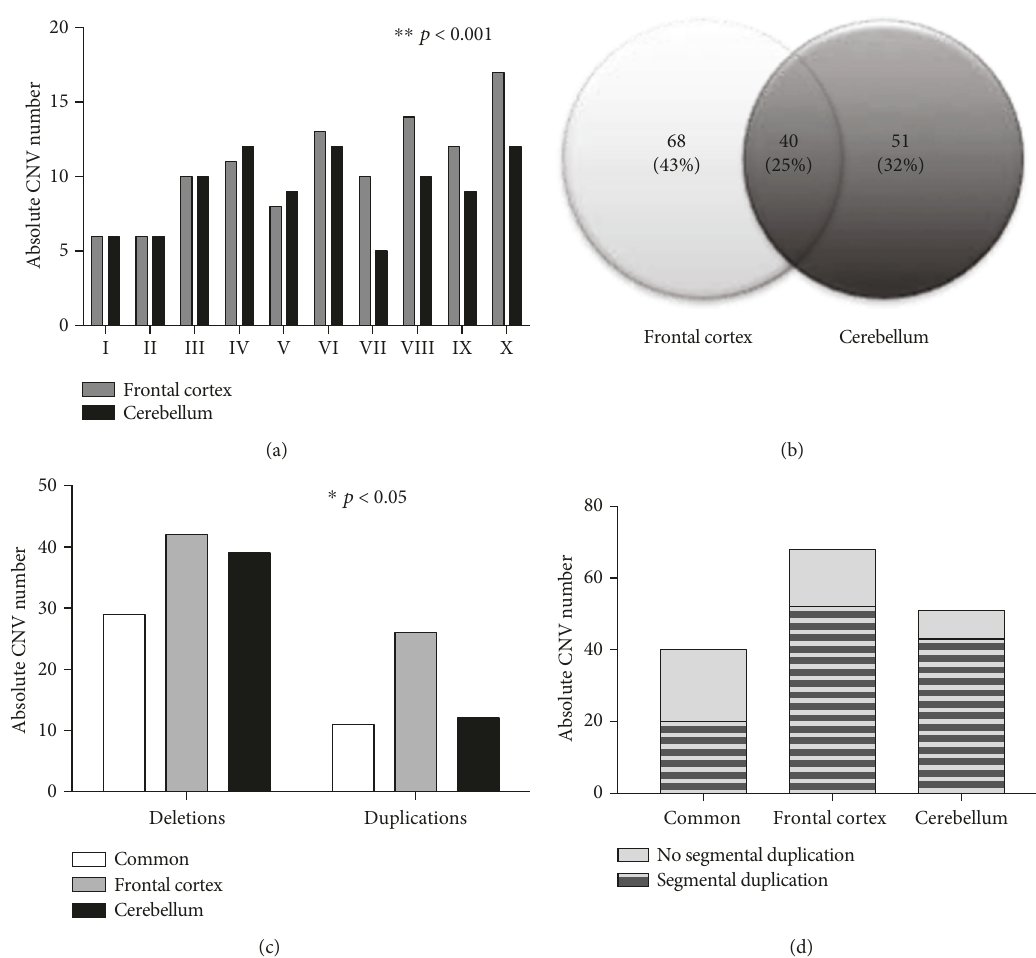
Figure 2: Distribution of DNA copy number variations (CNVs) between two neural tissues from the same individuals. (a) Comparison of the absolute number of CNVs detected in the frontal cortex and cerebellum from 10 paired individuals; ∗∗ p < 0 001 for comparison between individuals, two-way ANOVA. (b) Venn diagram showing the proportion of CNVs observed in the frontal cortex and cerebellum. (c) Total number of deletions and duplications observed in the CNVs in common to both neural tissues and in the unique CNVs from the frontal cortex and cerebellum; ∗ p < 0 05 for comparisons between the compared groups as well as deletions and duplications, two-way ANOVA. (d) Proportion of segmental duplications identi fi ed in the CNVs in common to both neural tissues and in the unique CNVs from the frontal cortex and cerebellum. Table 2: Comparison of length and gene content of the in common and unique CNVs from the frontal cortex and cerebellum. Copy number variation